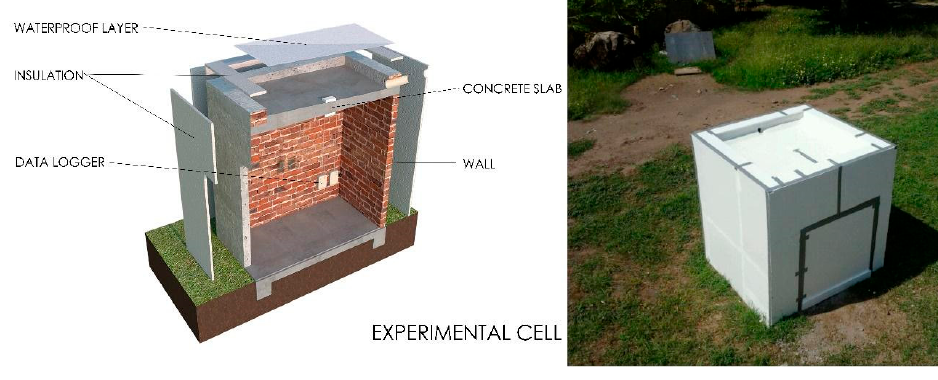
Figure 5. Cross section diagram of the experimental cell with its elements.